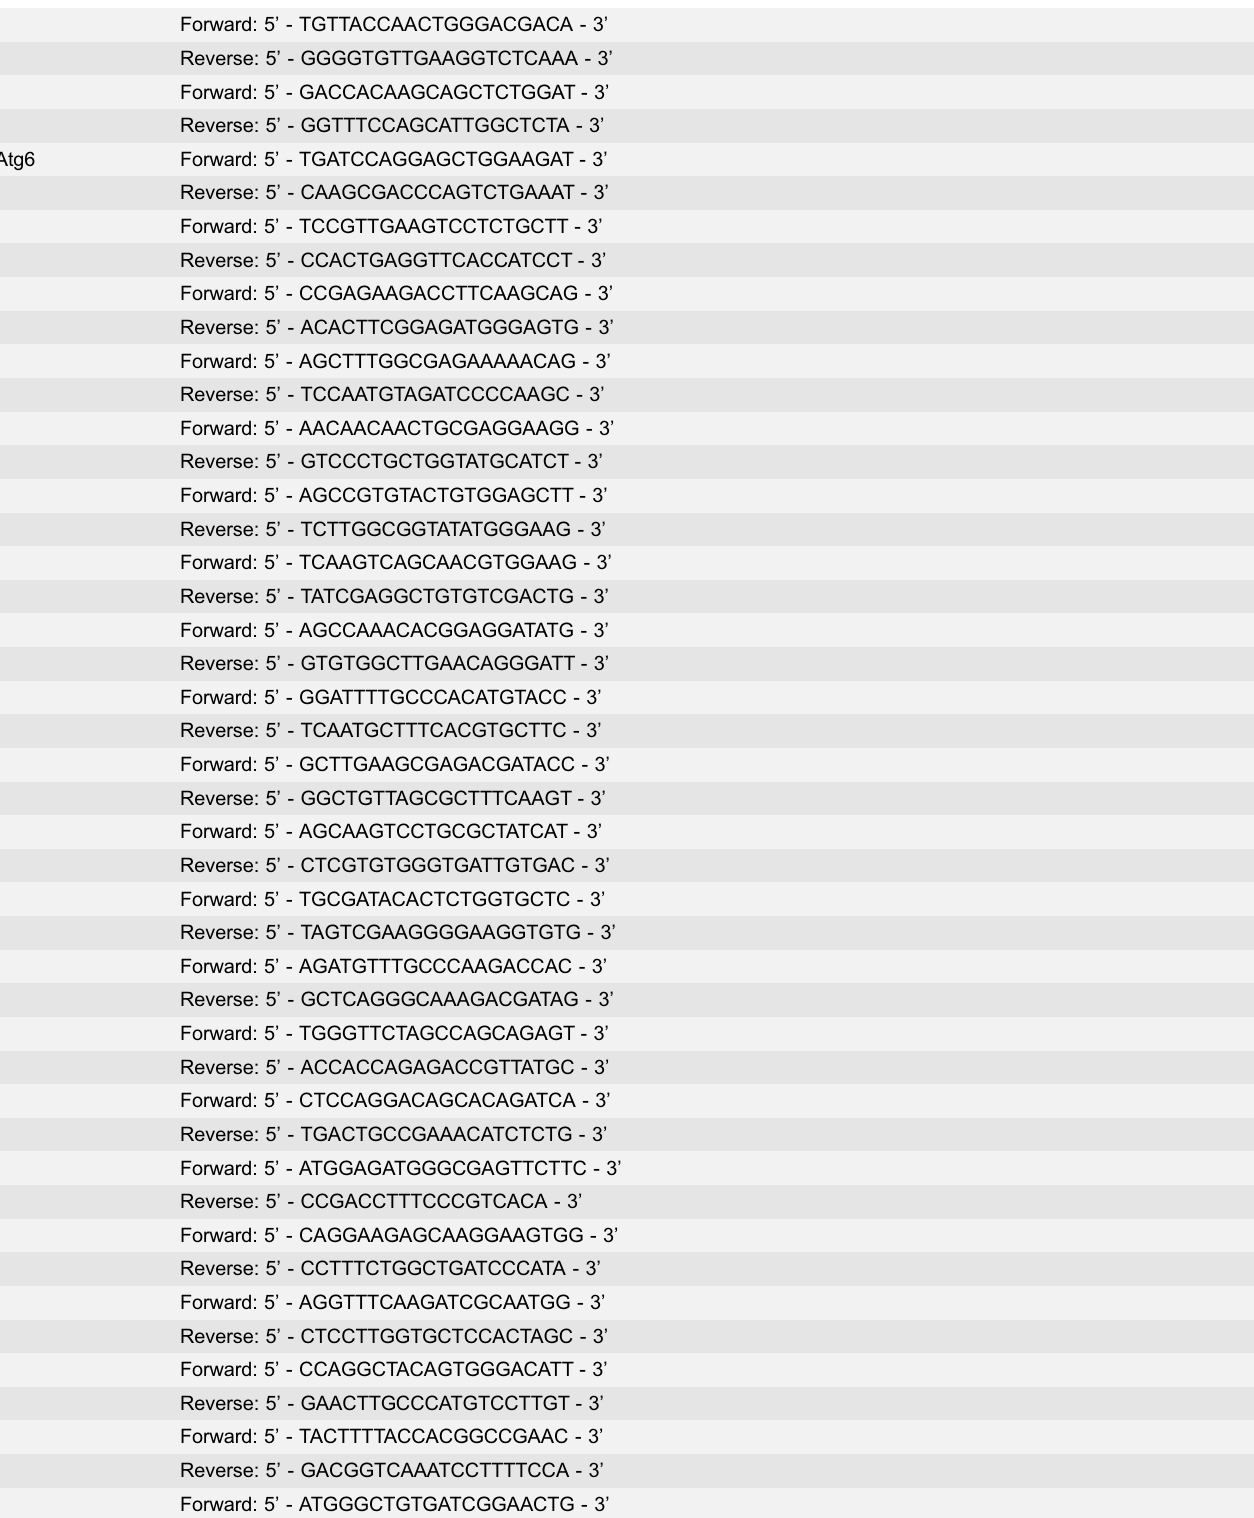
Table 1. RT-RCR Primers Used in This